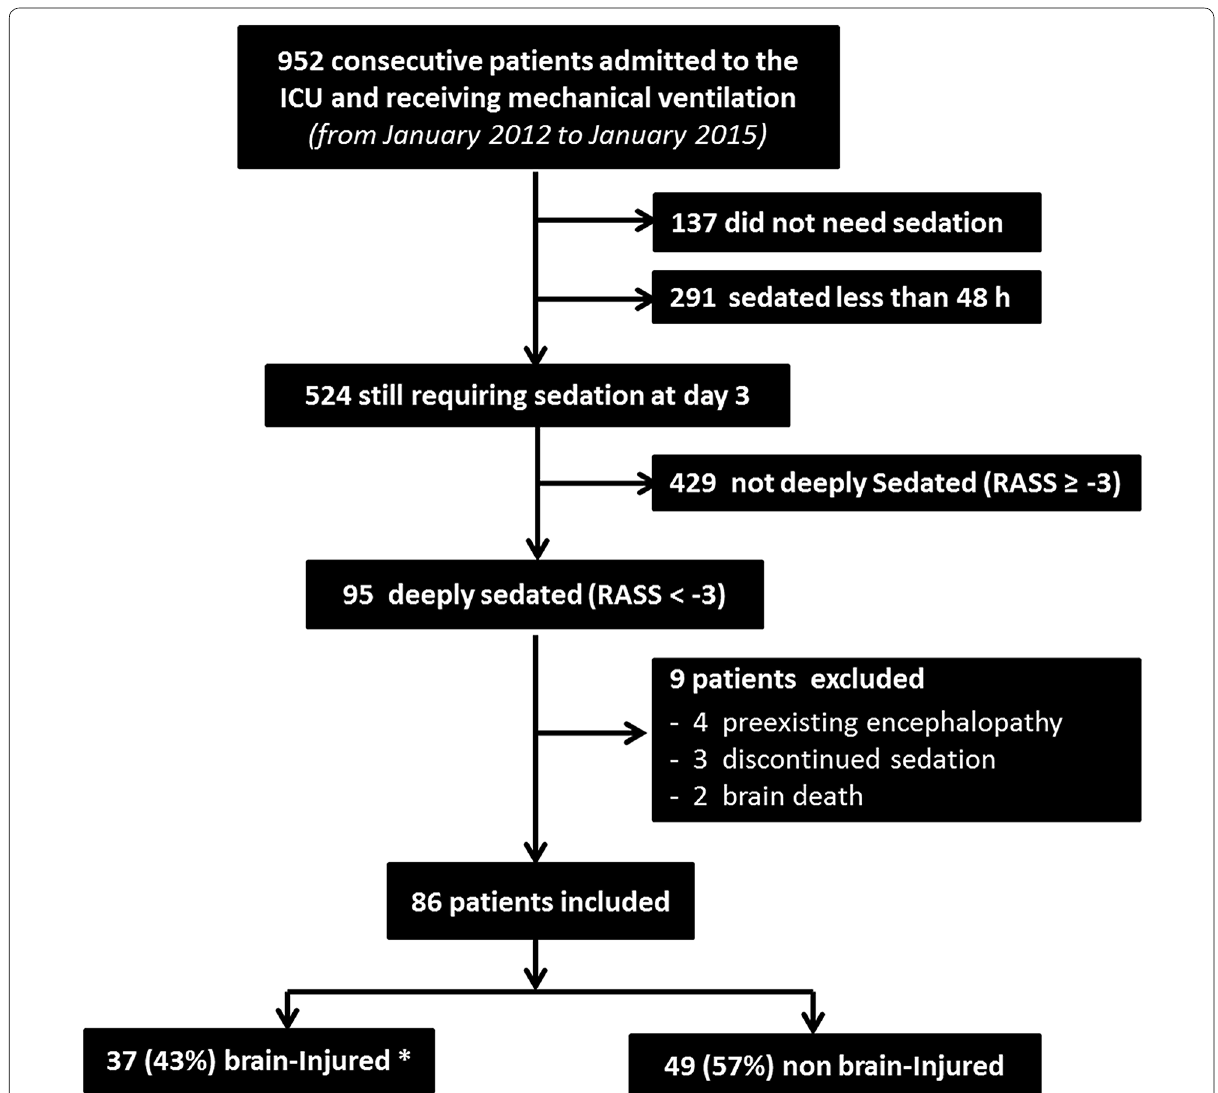
Fig. 1 Flowchart. *Brain‑injured patient was defined by admission to the ICU for acute brain